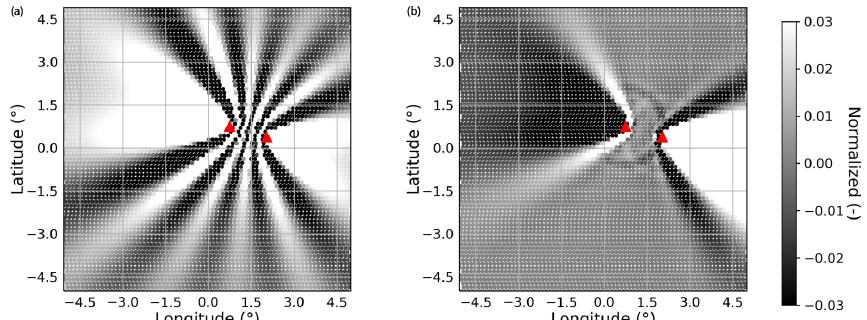
Figure 5. Illustration of sensitivity kernels. (a) Normalized vertical-component sensitivity kernel K zz ( x 1 , x 2 , ξ ) of full waveform L2 misfit χ fwi (Eq. 9). The station locations x 1 , x 2 are marked by red triangles. Frequency integration runs from 0Hz to the Nyquist frequency, but the source spectrum peaks at dominant frequency 0.05Hz and filters out everything above 0.1Hz. (b) Normalized sensitivity kernel K zz ( x 1 , x 2 , ξ ) of windowed asymmetry measurement χ A (Eq. 11). Similar figures can be obtained by adapting the Jupyter Notebook tutorial for noisi